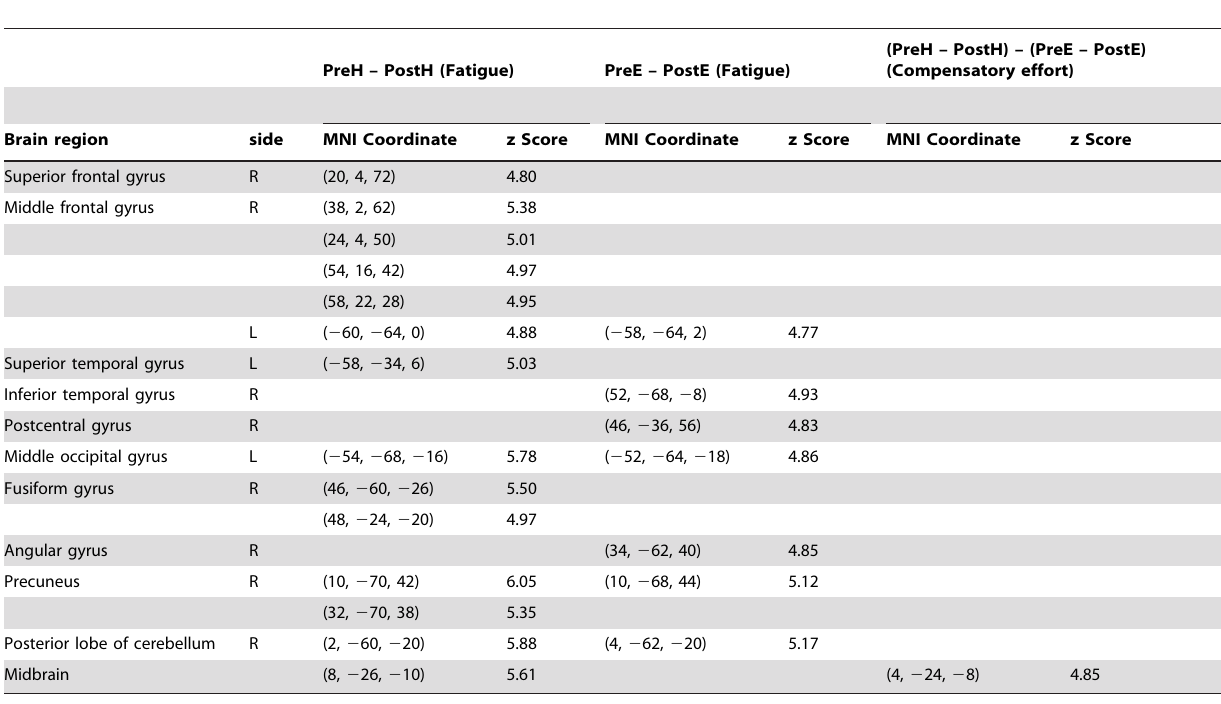
Table 1. Deactivation related to fatigue and compensatory effort (n